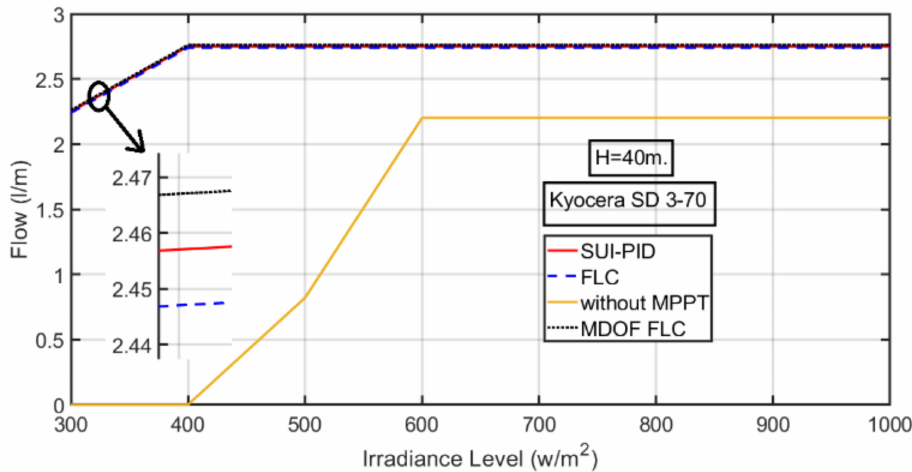
Figure 21. Performance analysis of the volume flow rate at a head of 40 m.